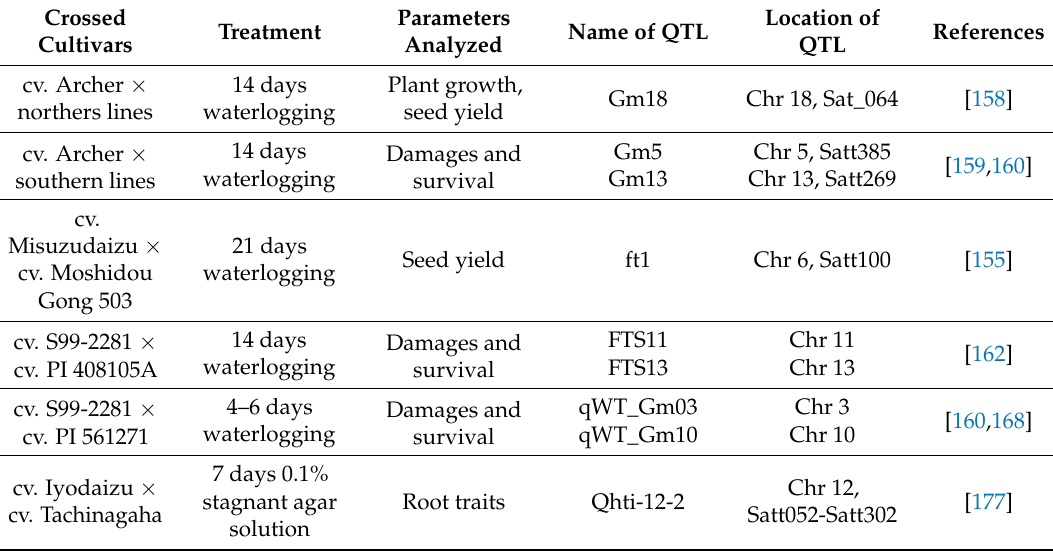
Table 4. QTLs associated with waterlogging tolerance in soybean ( Glycine max (L.) Merr.).